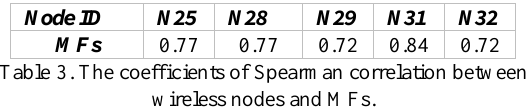
Table 3. The coefficients of Spearman correlation